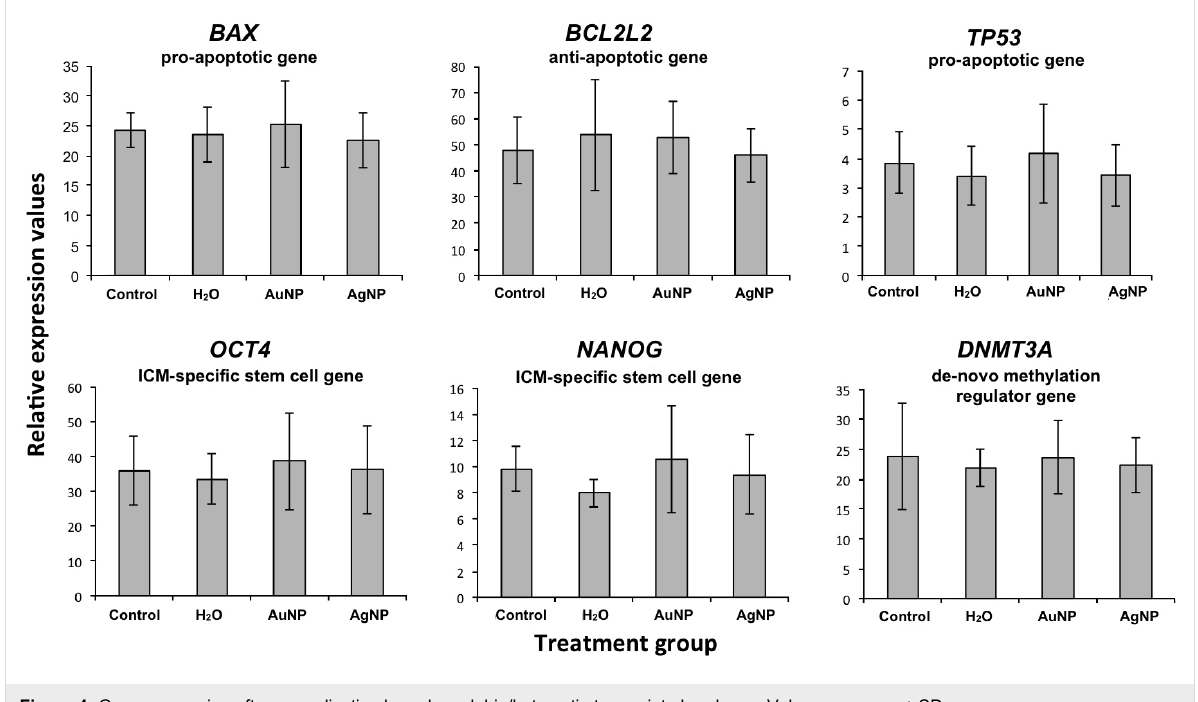
Figure 4: Gene expression after normalization based on globin/beta-actin transcript abundance. Values are mean ± SD.